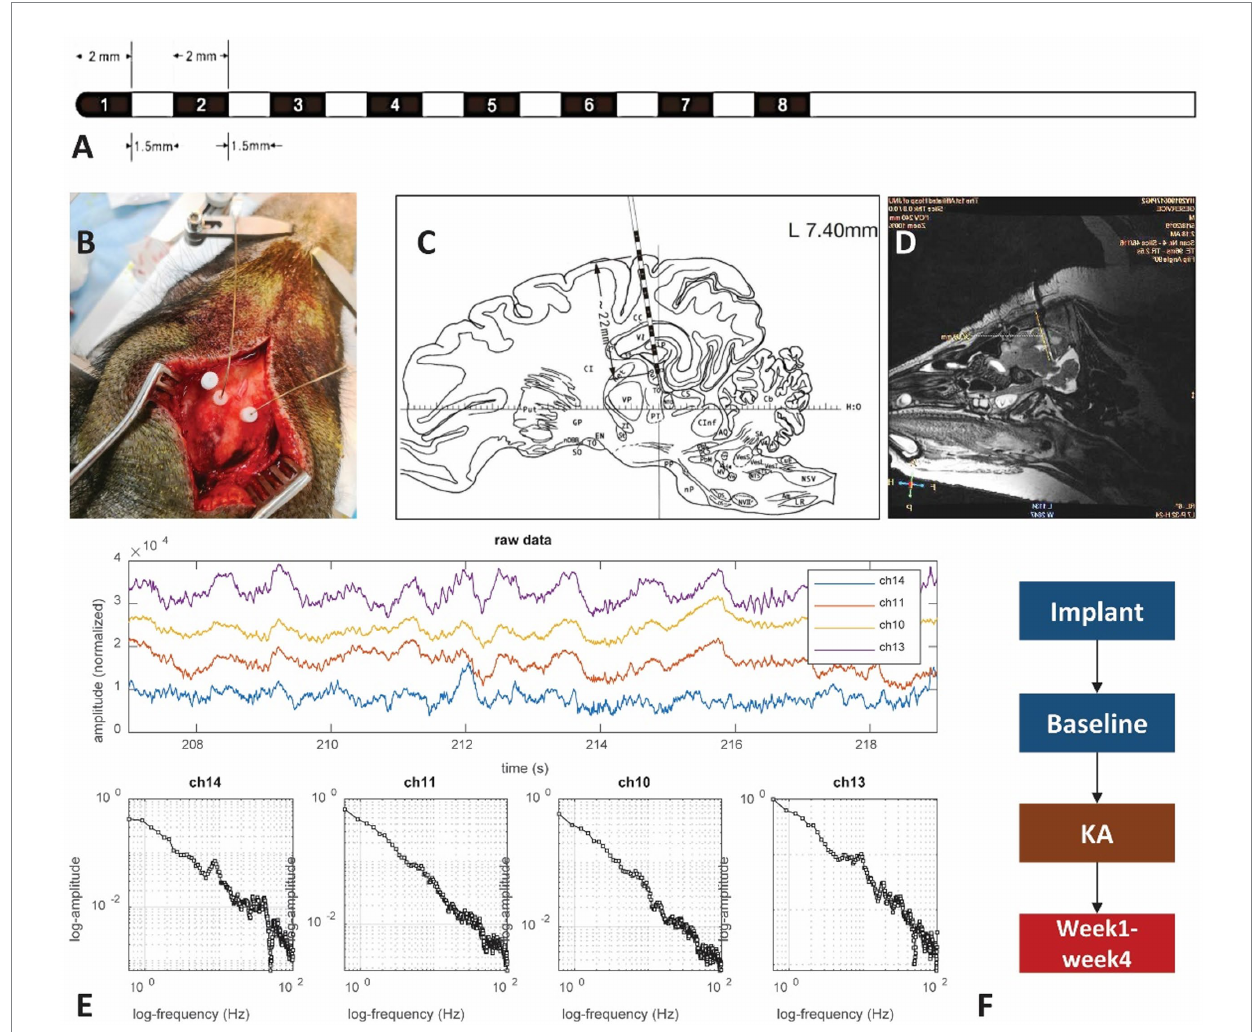
FIGURE 1 The experimental setup. (A) Illustration of the SEEG macroelectrode: the contacts on the electrode are labeled by black color and numbers. The contact is 2 mm in length with a gap of 1.5 mm between contacts and a dimension of 0.78 mm. (B) Photo showing the electrode implantation surgery. Hole marked by the letter “A” is preserved for KA injection. The other two dots connected with wires are electrodes. (C) Brain atlas of the electrode implantation. The distance from the superficial layer is about 22 mm, covering the sensorimotor cortex and hippocampus. Most of the time only the 6 contacts in the front are within the brain, with the corresponding channels 1–6 (left side) and 9–14 (right side). The contacts within the hippocampus area should be either from contacts 2–3 in the left or 9–11 from the right hemisphere. (D) MRI scan of the pig brain. The MRI scan has been used to verify the location of the SEEG electrode. (E) Examples of brain electrical activity (upper plots) and the results of multi-scale 1/f statistical behavioral analysis in the randomly selected epochs. The data indicate a clear near-linear decrease of log power with increasing log frequency from 0.5 to 100 Hz. The 50 Hz notch filter effect is visible in the channels that successfully reached the deep brain tissue. (F) The experimental